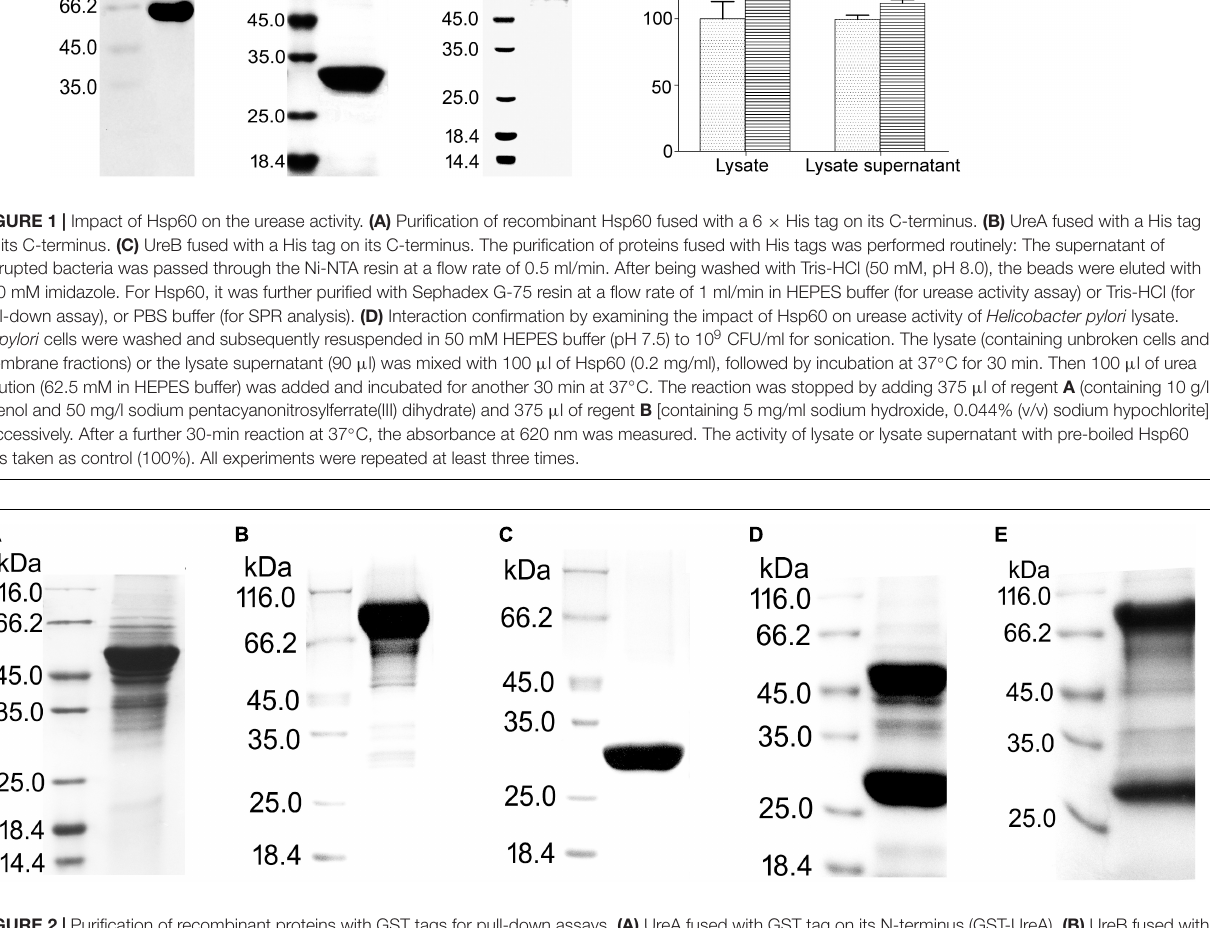
FIGURE 2 | Purification of recombinant proteins with GST tags for pull-down assays. (A) UreA fused with GST tag on its N-terminus (GST-UreA). (B) UreB fused with GST tag on its N-terminus (GST-UreB). (C) GST tag. (D) UreA fused with GST tag on its C-terminus (UreA-GST). (E) UreB fused with GST tag on its C-terminus (UreB-GST). The recombinant proteins with GST tags were all purified as follows: The bacterial cells were disrupted in Tris-HCl (50 mM, pH 8.0) and centrifuged at 11,000 rpm for 30 min. The supernatant was then incubated with glutathione Sepharose 4B beads overnight with gentle inversion. Next, the beads were washed three times with Tris-HCl (50 mM, pH 8.0) and eluted with glutathione (reduced form) to a final concentration of 10 mM. During the purification of UreA-GST and UreB-GST, a large amount of cleaved GST tag (about 26 kDa) was also eluted from the